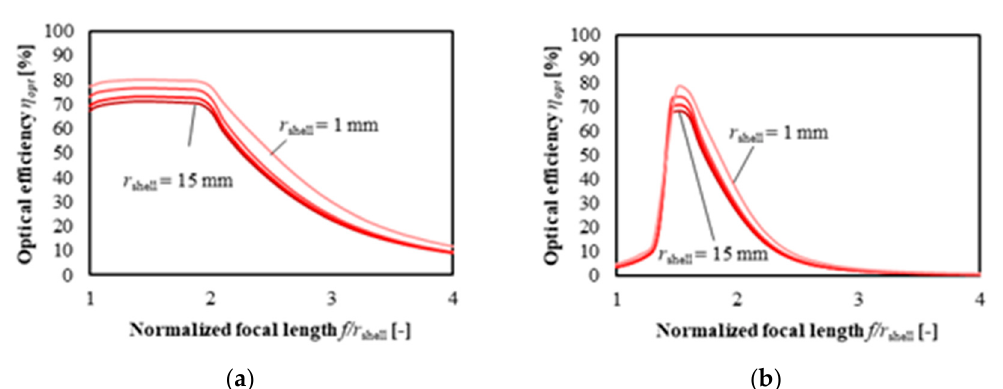
Figure 12. Simulated optical efficiency of the CSSP lens for varied normalized focal lengths across